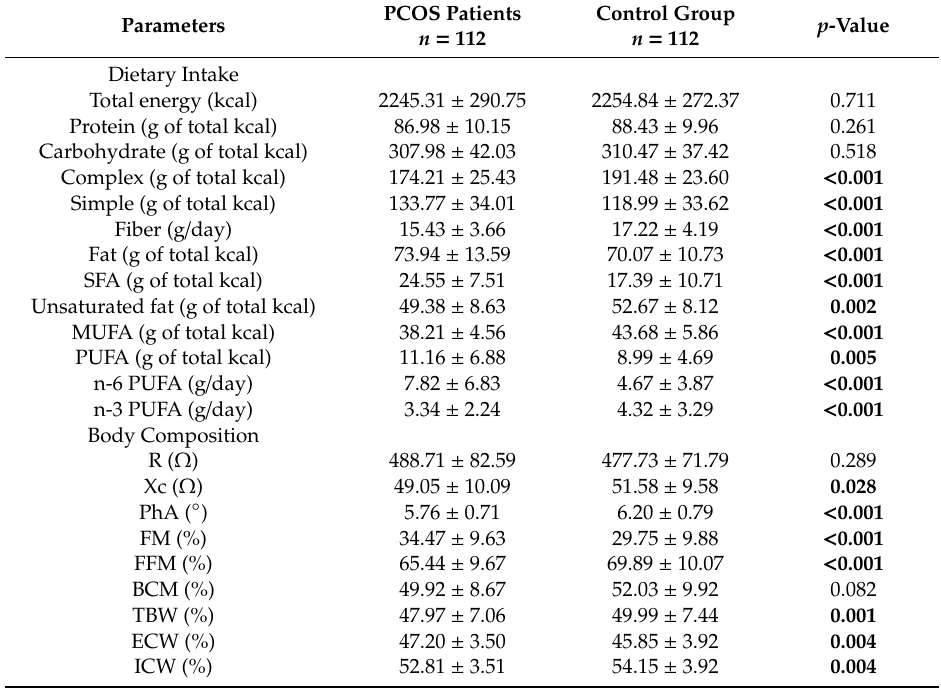
Table 3. Daily energy, nutrients intake and bioelectrical impedance analysis (BIA) parameters of the PCOS patients and control